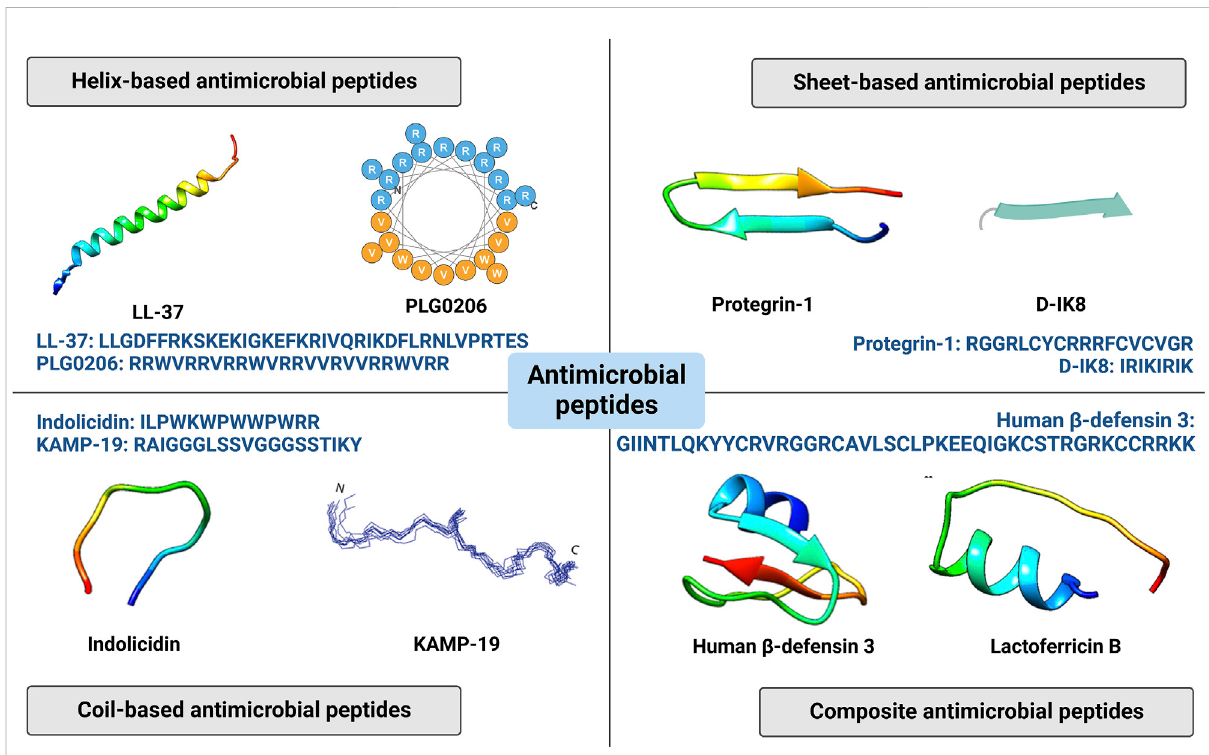
FIGURE 2 Four categories of antimicrobial peptides (helix based, sheet-based, coil-based and composite antimicrobial peptides) and related representative structures and sequences. Reprinted with permission from Di Somma et al. (2020). (Copyright 2020; Biomolecules), Huang et al. (2021). (Copyright 2021; Antibiotics), and Lee et al. (2016). (Copyright 2020; Frontiers in